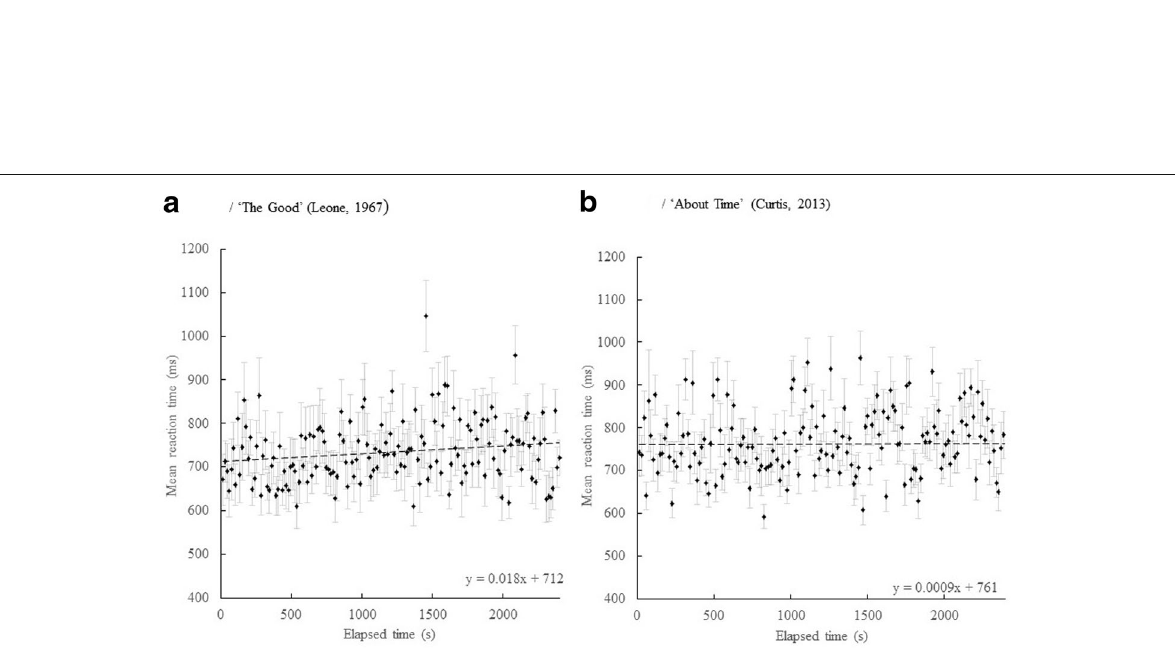
Fig. 3 Deshuffled films, mean secondary reaction time (RT) (ms) across participants, for each time point, plotted against elapsed time (s). a / The Good. b / About Time. Error bars are 95%